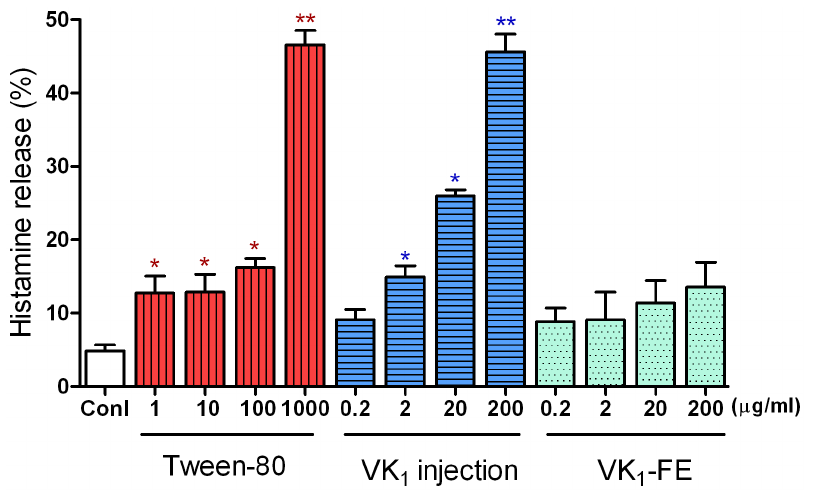
Figure 3. Effect of vitamin K 1 (VK 1 ) injection on histamine release in RBL-2H3 cells. RBL-2H3 cells were treated with the different drugs for 30 min. The supernatants were collected and measured by spectrofluorometry. PBS was used as a blank, and the supernatant from cells stimulated with Triton was considered to represent the total histamine release. The histamine release rates are shown as the mean 6 SE, n=6. * P , 0.05, ** P , 0.01 vs. control (conl). VK